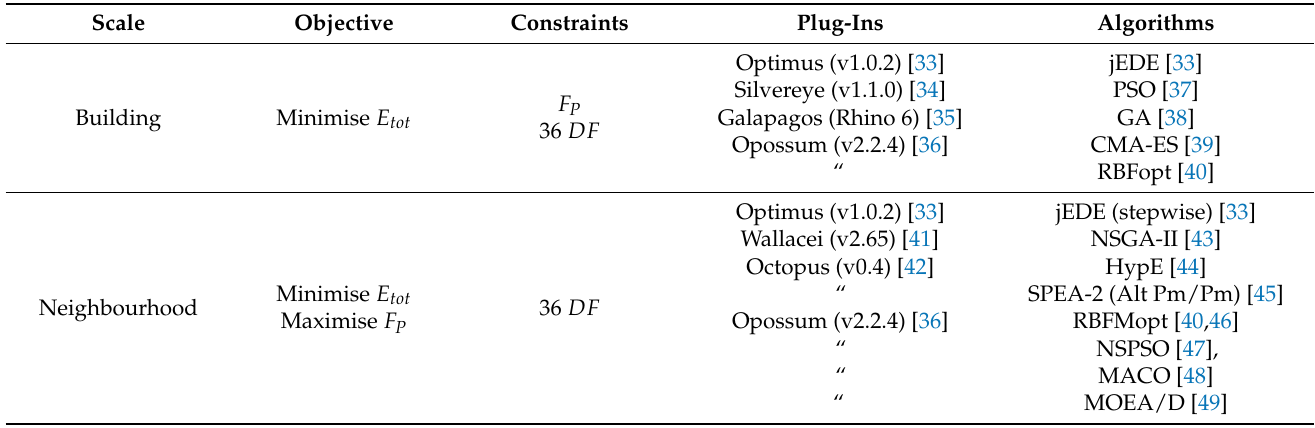
Table 2. Overview of the optimisation algorithms used in this